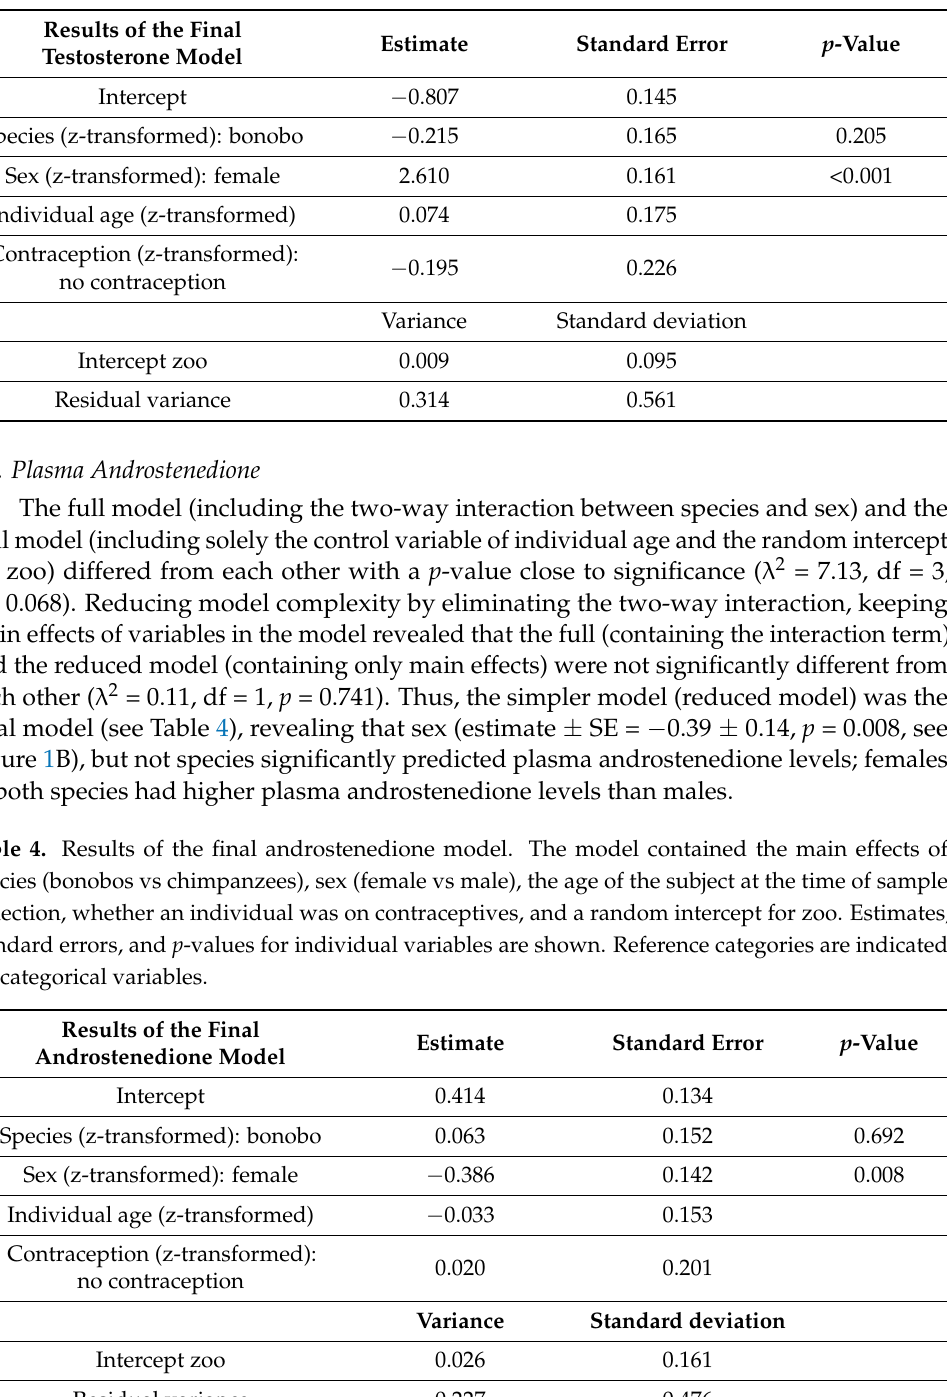
Table 3. Results of the final testosterone model. The model contained the main effects of species (bonobos vs chimpanzees), sex (female vs male), the age of the subject at the time of sample collection, whether an individual was on contraceptives, and a random intercept for zoo. Estimates, standard errors, and p -values for individual variables are shown. Reference categories are indicated for categorical variables.